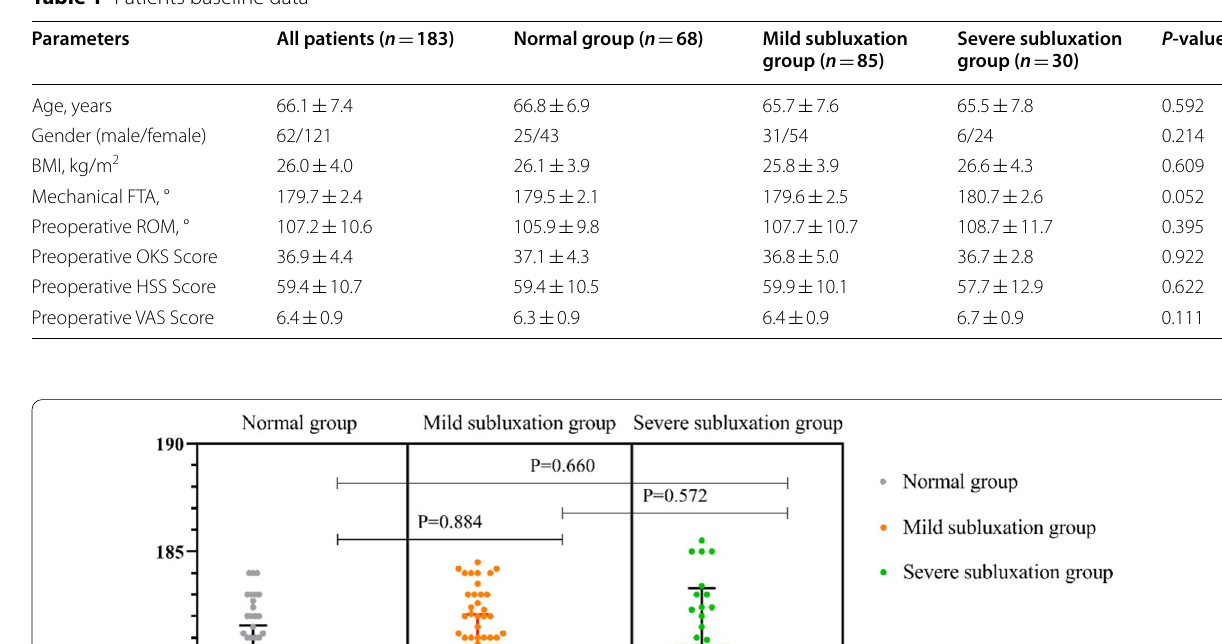
Table 1 Patients baseline data